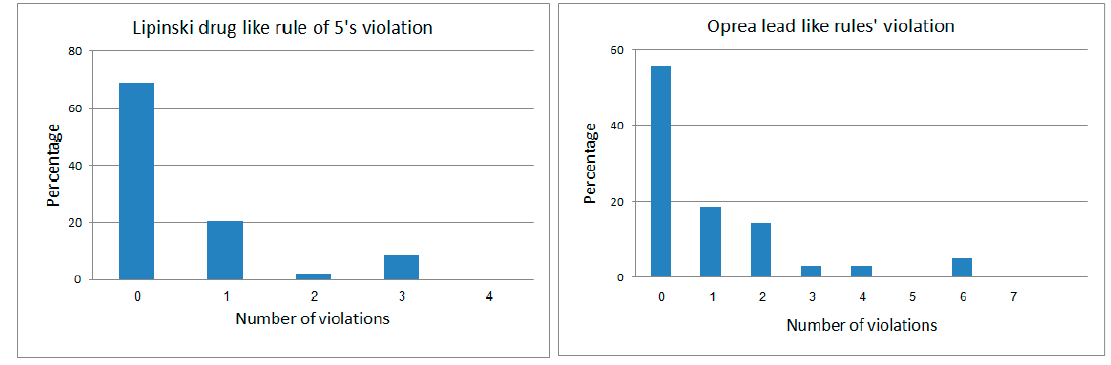
Figure 3. Violation distribution of anti-diabetic drugs for Lipinski’s rule of drug-likeness and Oprea’s rule for lead likeness.